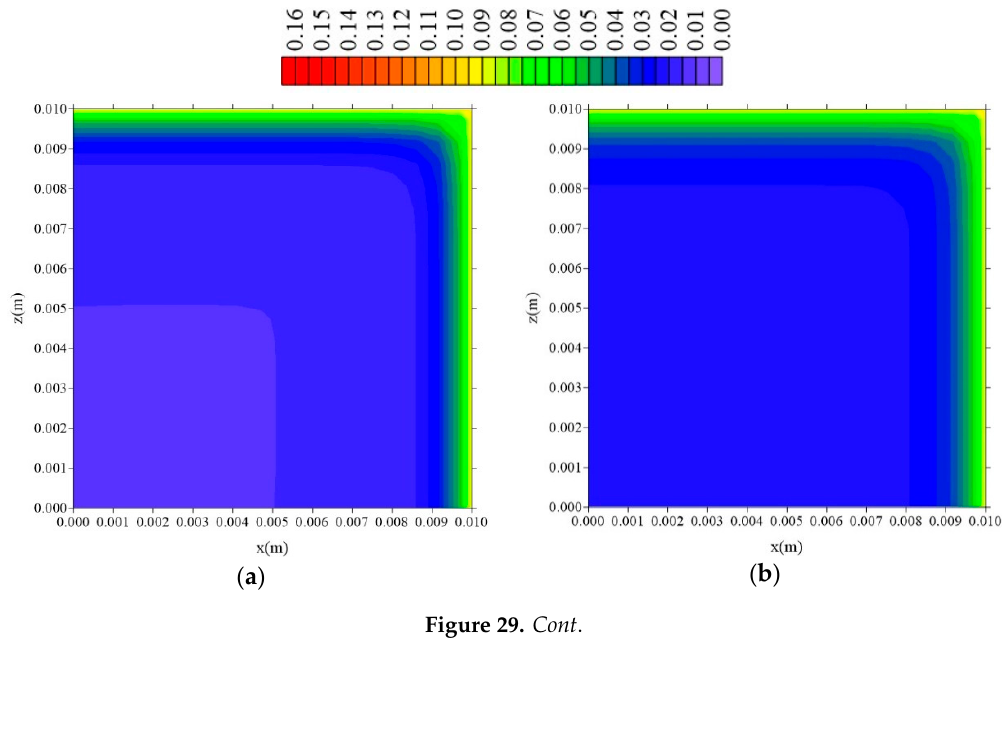
Figure 28. Distribution of entrapped solute concentration (S in kg/kg) in plan z = R z /2 for different distances l y (t = 211 h, Cases 9, 11, and 12). In which ( a ) l y = 0.001 m; l x = 0.1 m and l z = 0.1 m ; ( b ) l y = 0.01 m; l x = 0.1 m and l z = 0.1 m ; ( c ) l y = 0.1 m; l x = 0.1 m and l z = 0.1 m .